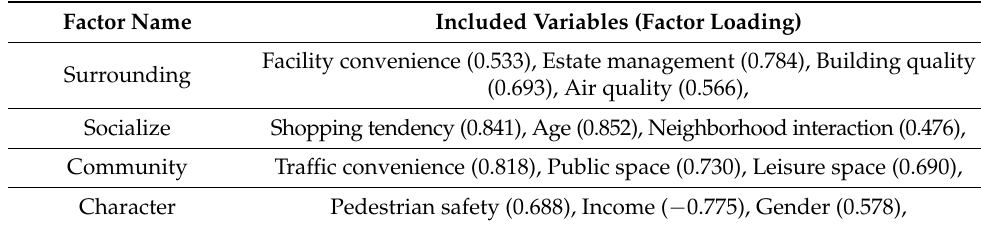
Table 5. Exploratory factor analysis of Nanhuan.